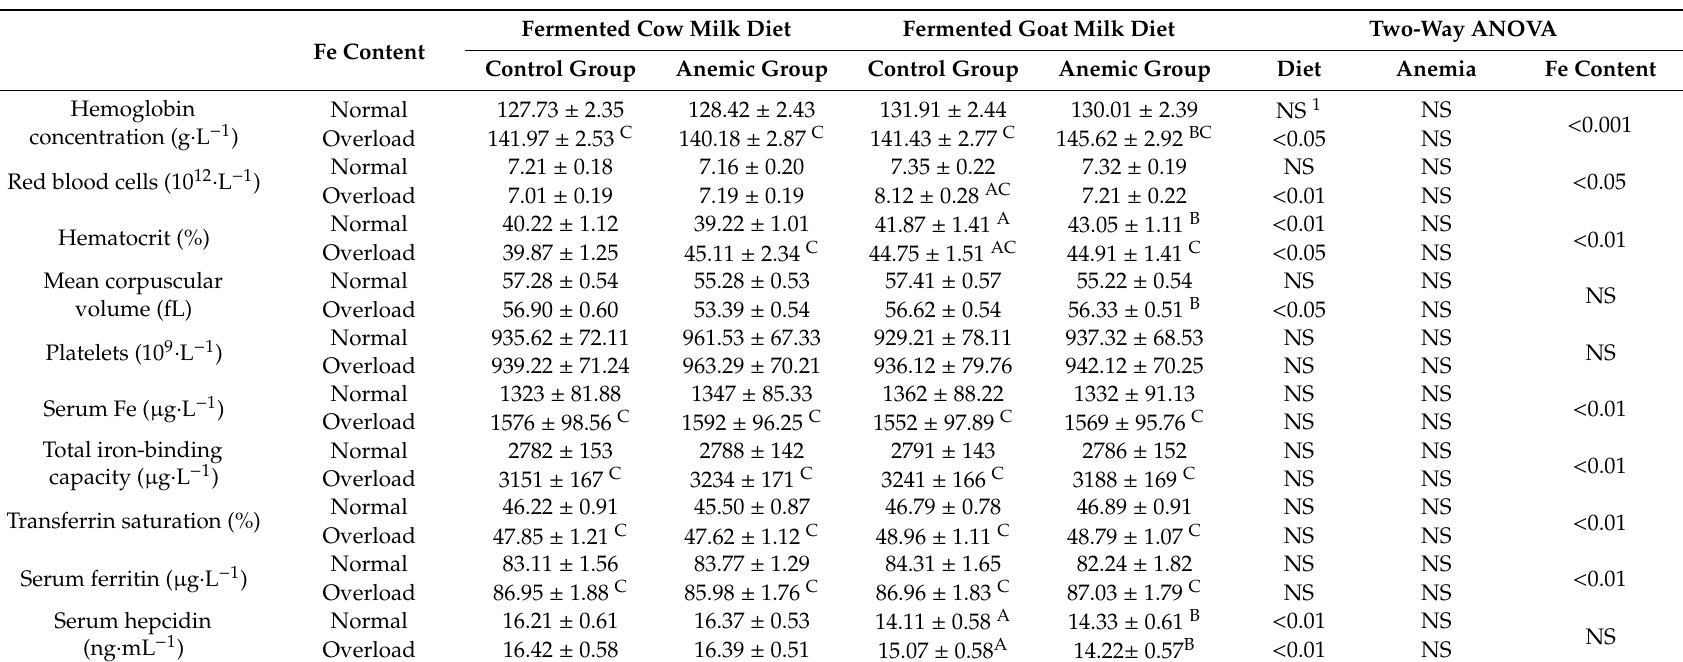
Table 2. Hematological parameters from control and anemic rats fed for 30 days with fermented cow or goat milk-based diets with normal Fe content or Fe overload ( n = 10 animals per